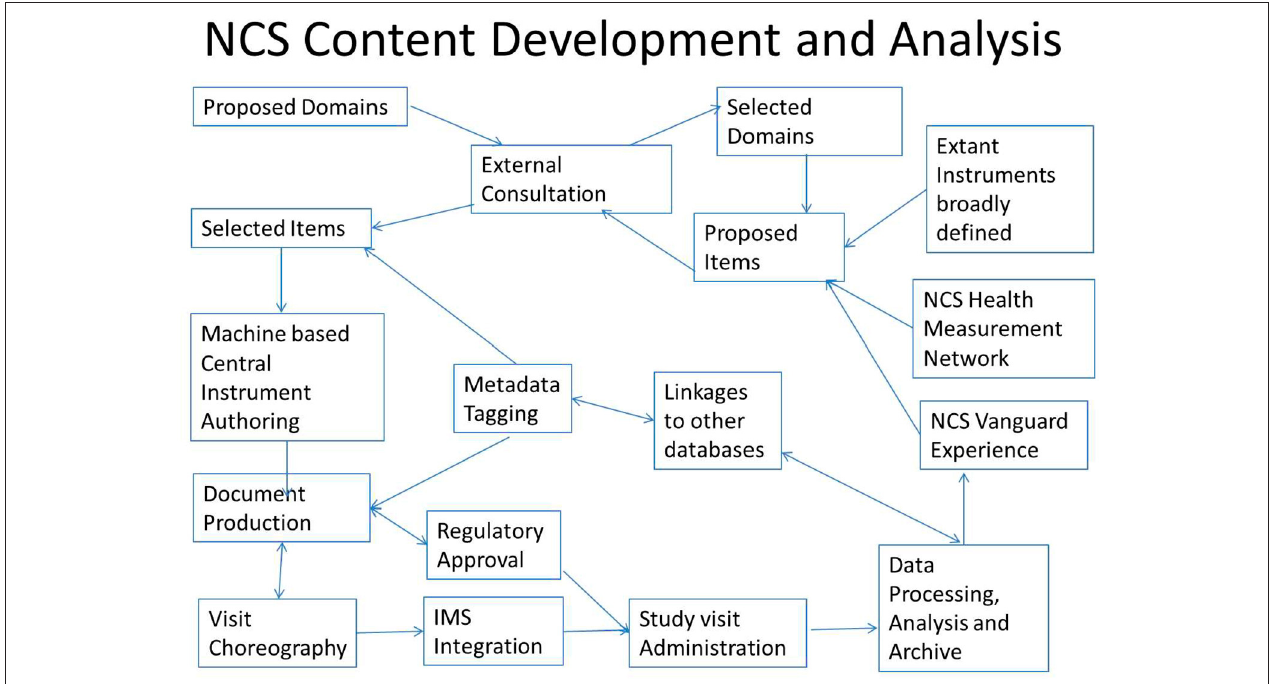
FIGURE 1 | Study content development cycle. IMS, Information Management